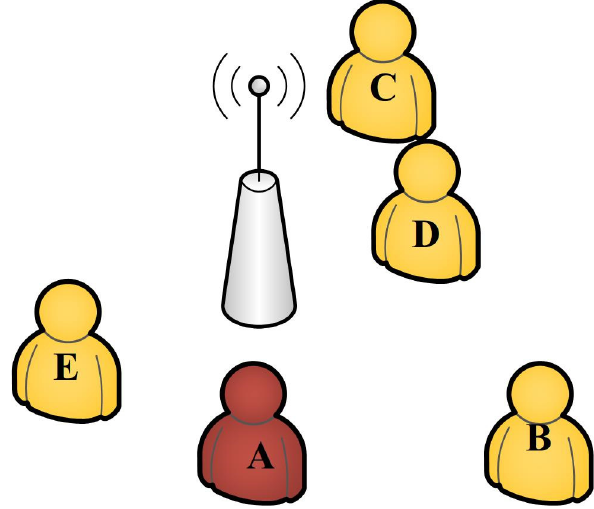
Figure 2. Using base stations to confirm potential infected people. The person in red is COVID-19- positive. Individuals in yellow are seen as risky.